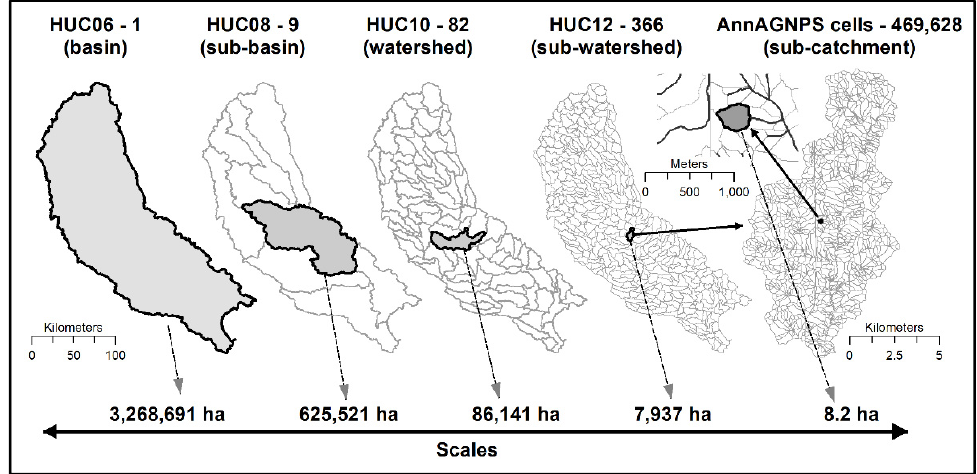
Figure 4. Illustration of the multiscale analysis from sub-catchments (AnnAGNPS cells) representing field-scale conditions to sub-basin (HUC08) scale representing regional conditions.